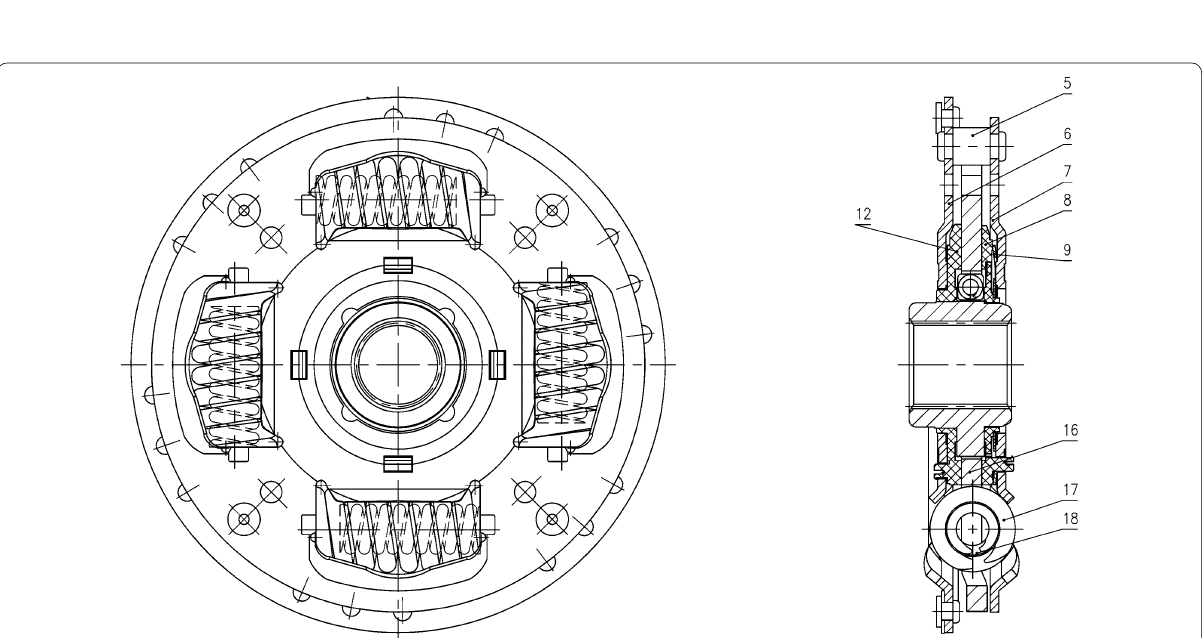
Figure 3 Diagram of main damping system of traditional clutch-driven disc assembly. 5. Stop pin, 6. Driven disc, 7. Retain plate, 8. Positioning ring, 9. Belleville washer, 12. Positioning ring, 16. Disc hub, 17. Spring, 18.